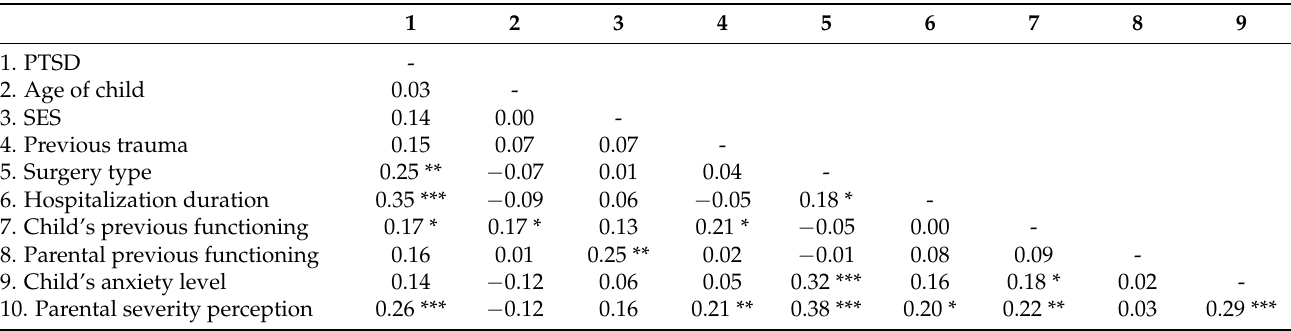
Table 3. Correlations between PTSD and background and screening variables—Jews ( n = 151).